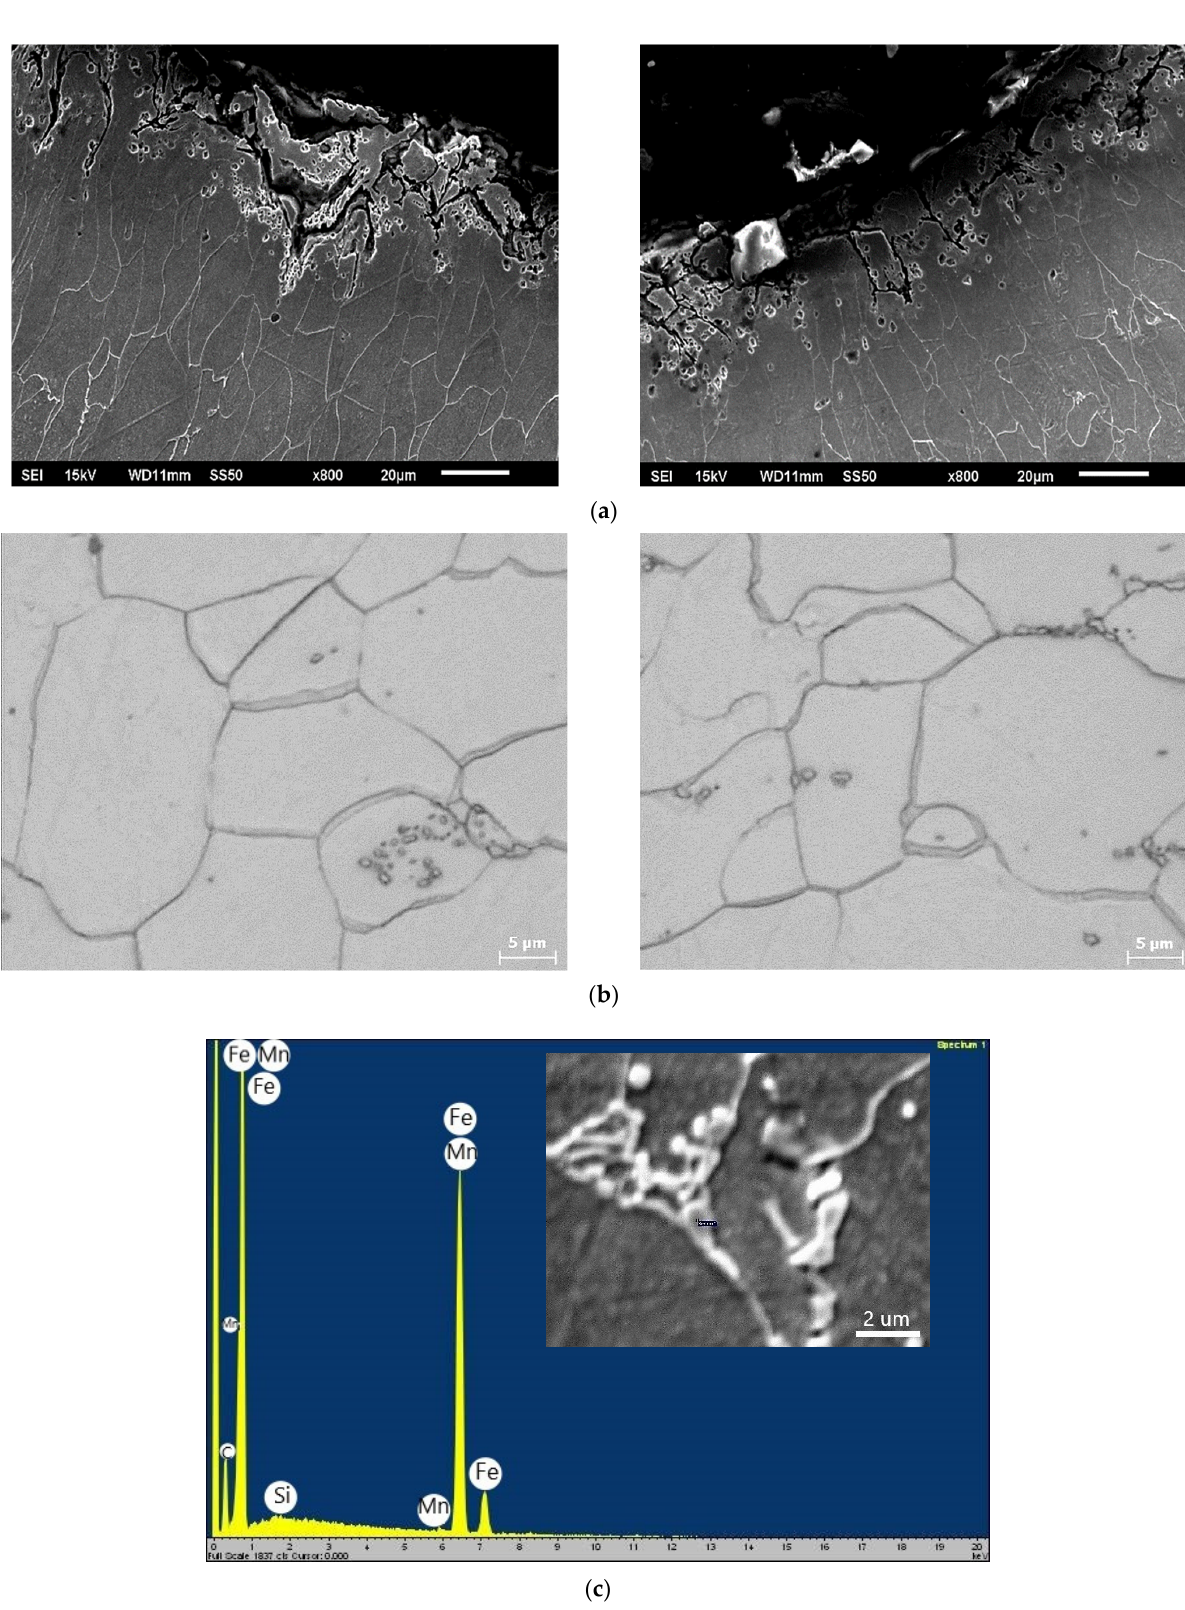
Figure 10. Microstructure of the rivet after fracture during the forming process ( a ) rivet flange sur ‐ face (SEM) ( b ) visible Fe 3 C III tertiary cementite through grain boundaries (LM), ( c ) chemical analysis of (Fe,Mn) 3 C III tertiary cementite (SEM ‐ EDS).